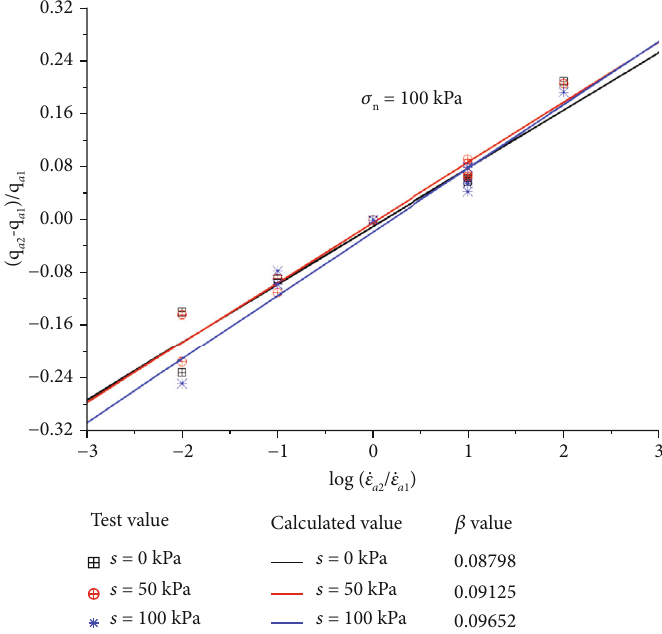
Figure 9: β value of reticulate red clay with di ff erent matric suction ( σ